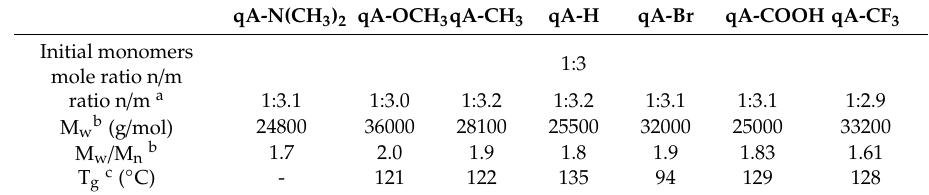
Copolymers from radical polymerization of 10% methacrylic monomers in N,N’-dimethylformamide (DMF) at 80 ◦ C (argon atmosphere, initiator—AIBN